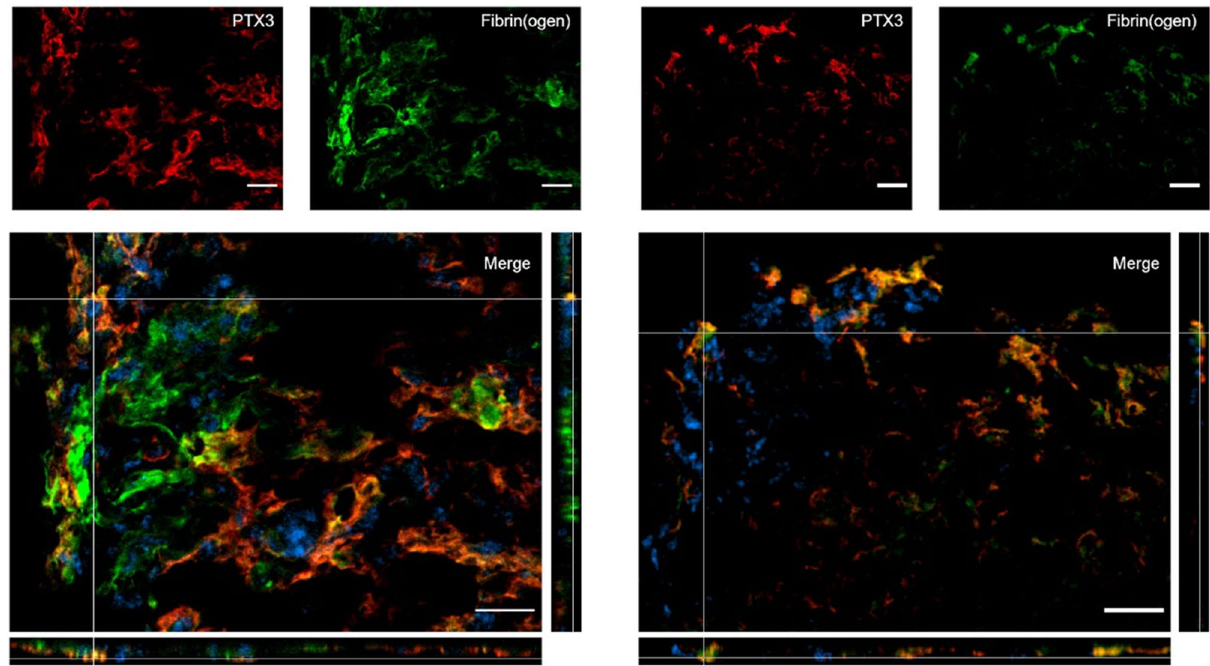
Figure 6. PTX3 co-localization with fibrin(ogen) in the contused cortex 1 and 2 weeks after TBI. PTX3 (red) co-localized with fibrin(ogen) (green) at 1w (left) and 2w (right) after TBI. Nuclei are in blue. Images are representative of at least two independent experiments. Scale bar = 20 µm.